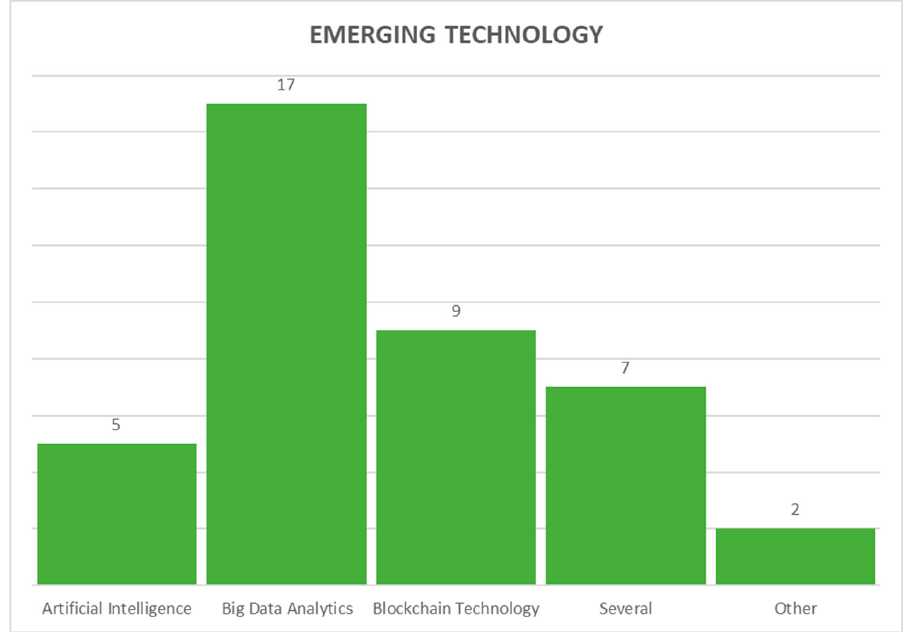
Figure 5. Emerging technologies studied in the sample.